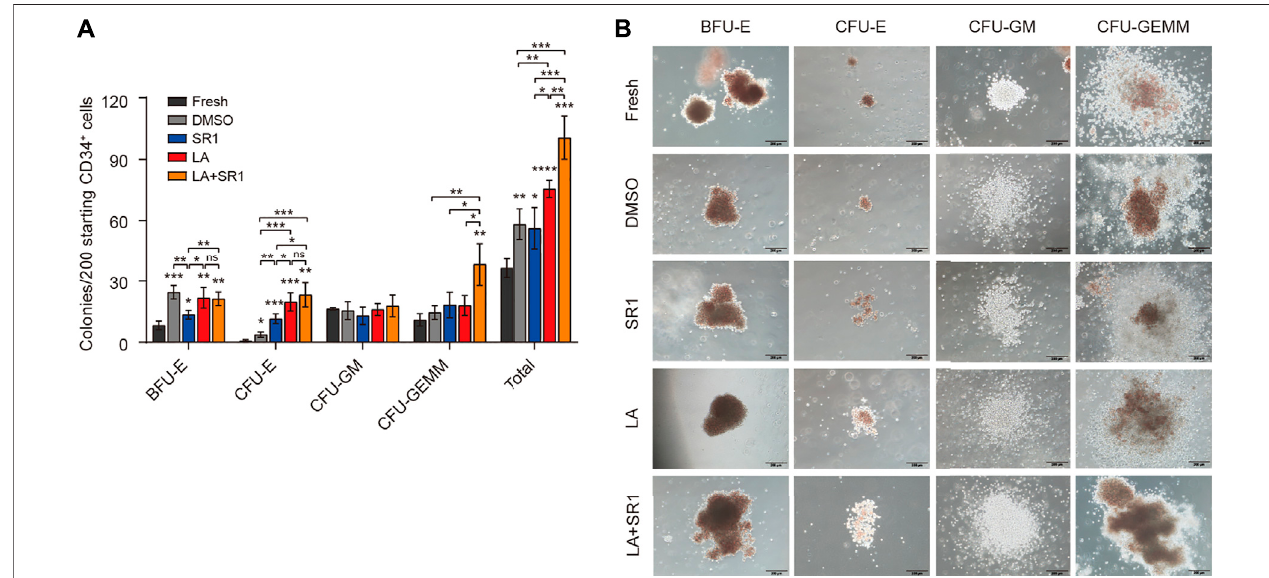
FIGURE 3 | LA enhanced the short-term clonogenic capacity of HSPCs in vitro . (A) Colonies derived from LA-treated (10 µM) cells in serum-free 4-d system following an additional 14-d culture in H4434 methylcellulose ( n = 3). All data represent the means ± SD. Compared with fresh unless speci fi ed. * p < 0.05, ** p < 0.01, *** p < 0.001, **** p < 0.0001 and ns = not signi fi cant by two-tailed unpaired Students ’ t -test. (B) Representative morphological images of CFU colonies (BFU-E, CFU-E, CFU-GM, CFU-GEMM). Scale bar, 200